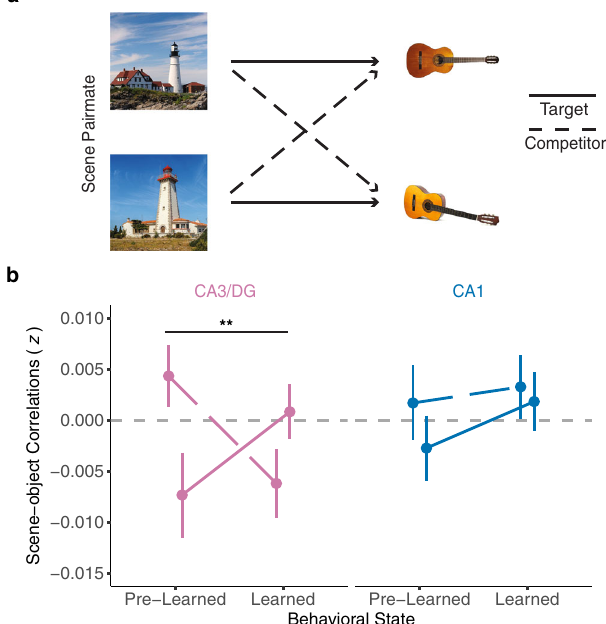
Fig. 4 Scene-object similarity as a function of behavioral state. a Example associations between scene pairmates and objects. The scene-object similarity was calculated by correlating activity patterns evoked during the scene exposure phases (at different behavioral states) and the object exposure phases. Target similarity refers to correlations between a given scene and the object with which it was studied. Competitor similarity refers to correlations between a given scene and the object with which its pairmate was studied. b Scene-object similarity as a function of object relevance (target, competitor), ROI (CA3/dentate gyrus, pink; CA1, blue), and behavioral state (pre-learned round, learned round). Mean correlations between unrelated scenes and objects (across pairmate similarity; not shown) were subtracted from target and competitor similarity values. For CA3/dentate gyrus (CA3/DG), there was a signi fi cant interaction between behavioral state and object relevance ( p = 0.002, repeated measures ANOVA). Note: ** p < 0.01. No correction for multiple comparisons was applied given the a priori predictions for CA3/dentate gyrus. Data were presented as mean ± SEM and all data re fl ect n = 31 independent participants. Source data are provided as a Source Data fi